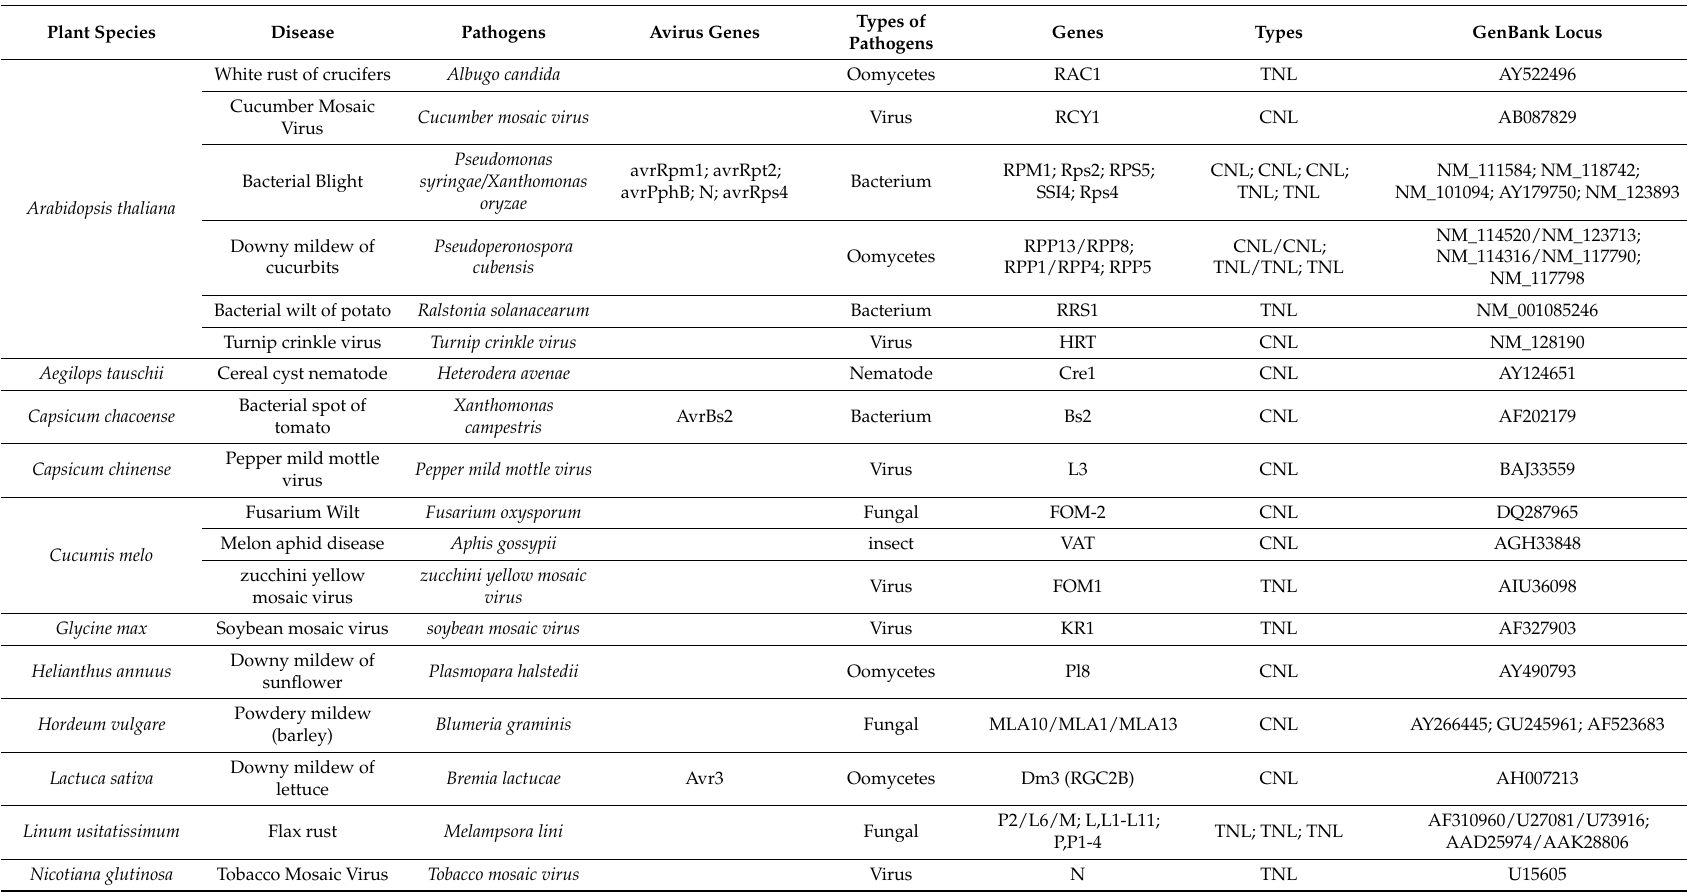
Table 2. The validated disease resistance genes and their pathogens in plants. The data were derived from PRGDB